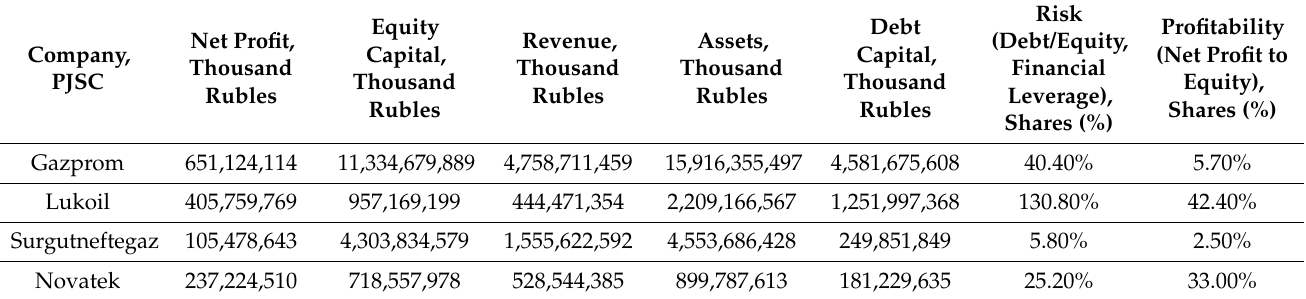
Table 1. Financial analysis parameters of companies for rating.